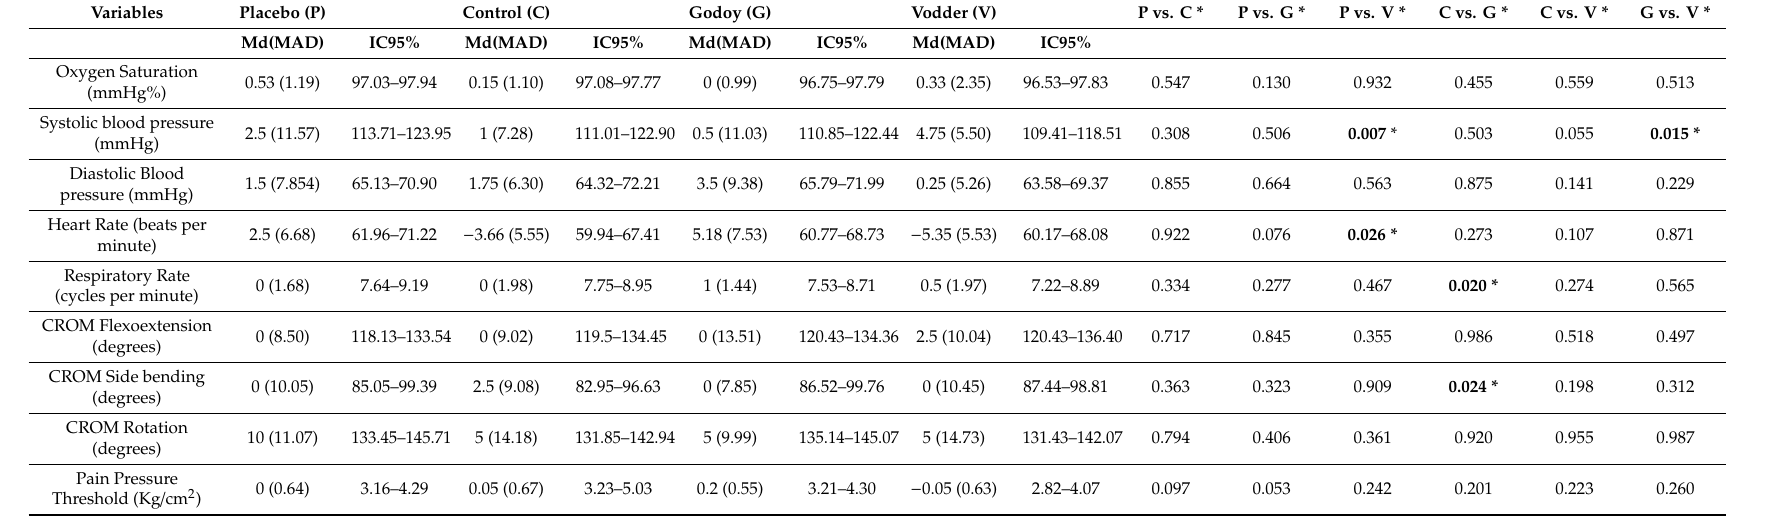
Table 1. Results of the outcomes expressed in di ff erences of Medians (interquartile